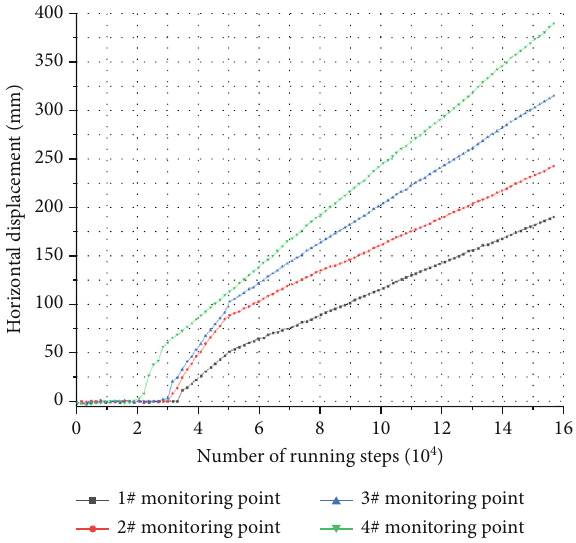
Figure 16: Horizontal displacement changes of slope monitoring points.